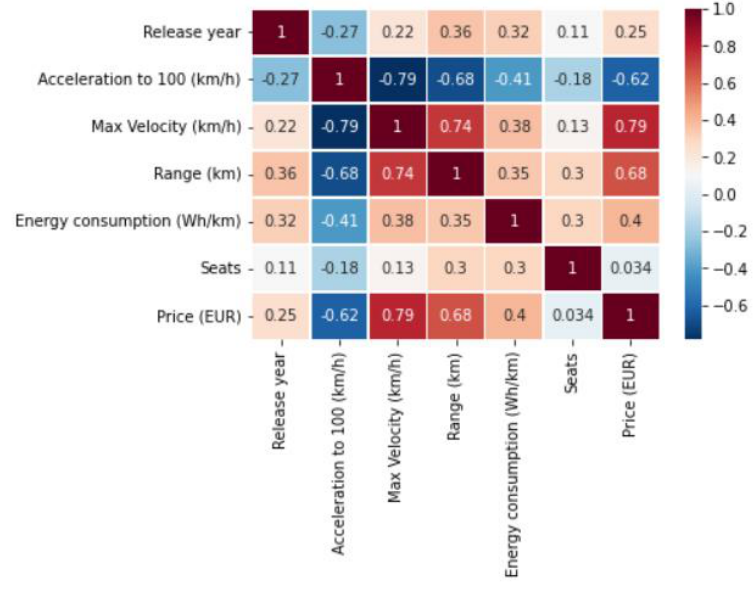
Figure 8. Heatmap Pearson ’ s correlation coefficient for the analyzed parameters.